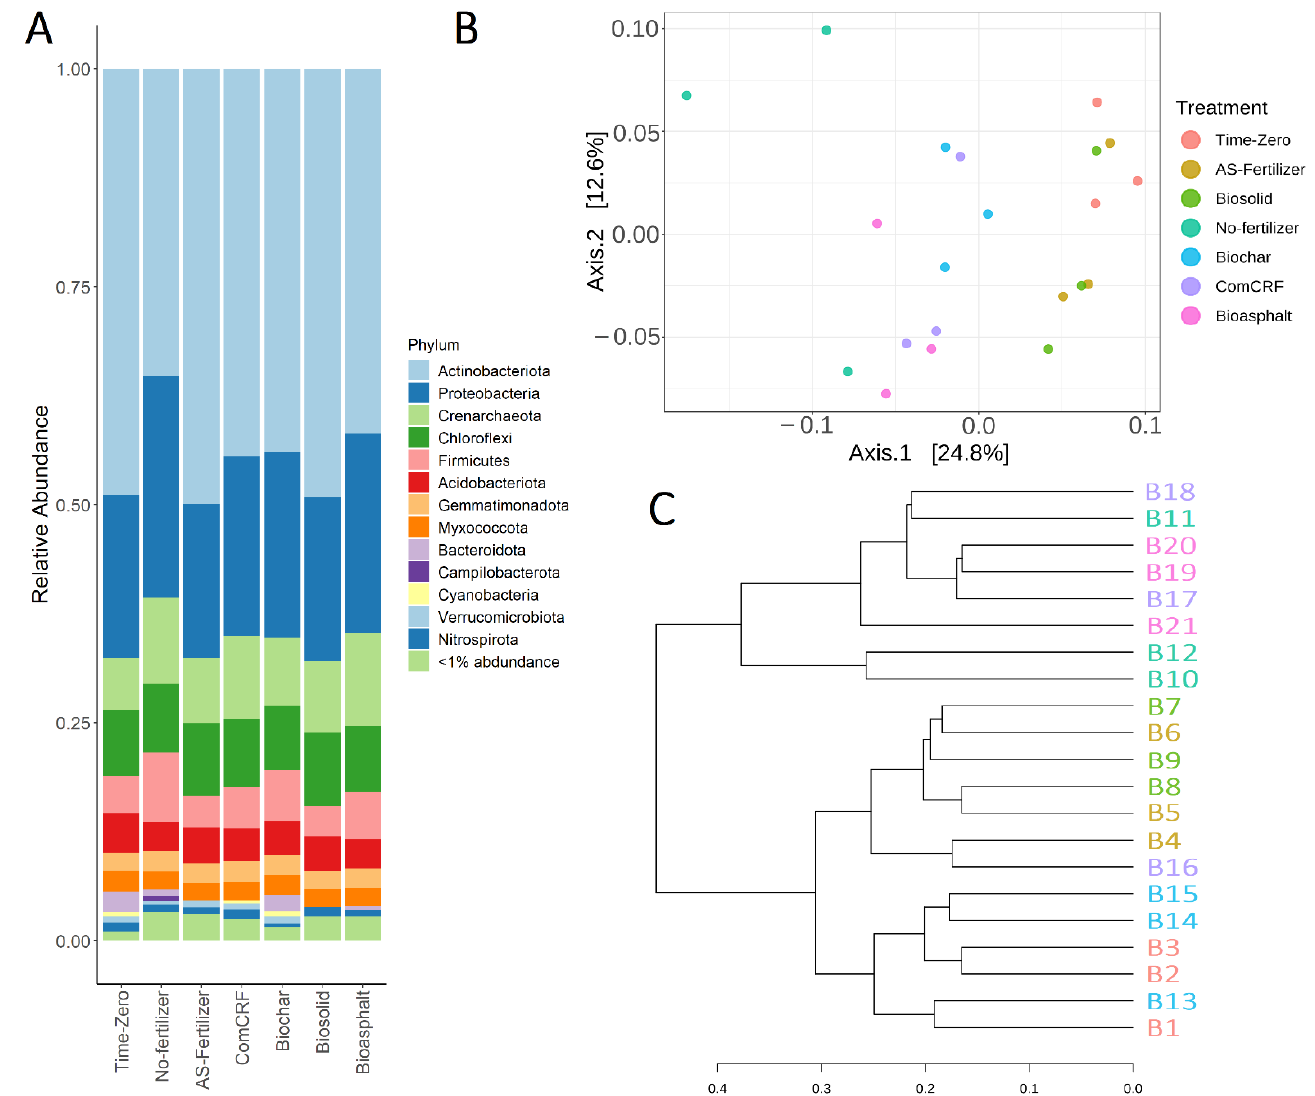
Figure 1. The prokaryotic community in soil at phylum level ( A ), Beta-diversity [PERMANOVA] F-value: 1.8188; R-squared: 0.43804; p -value < 0.001 ( B ), and hierarchical clustering using “ Ward ” clustering algorithm and Bray-Curtis Index as distance measure ( C ).